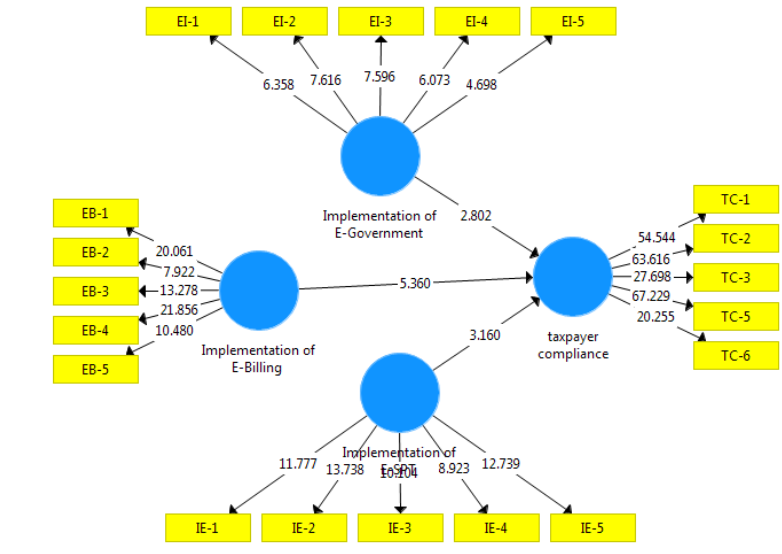
Fig. 3. Hypothesis testing